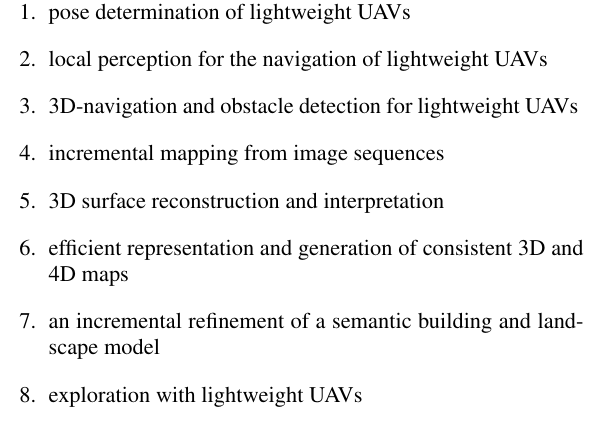
Figure 1: Use case of a user semantic mission planing. Is a person in the second floor at the back of the building? ( c (cid:13) Wolfgang F¨orstner,